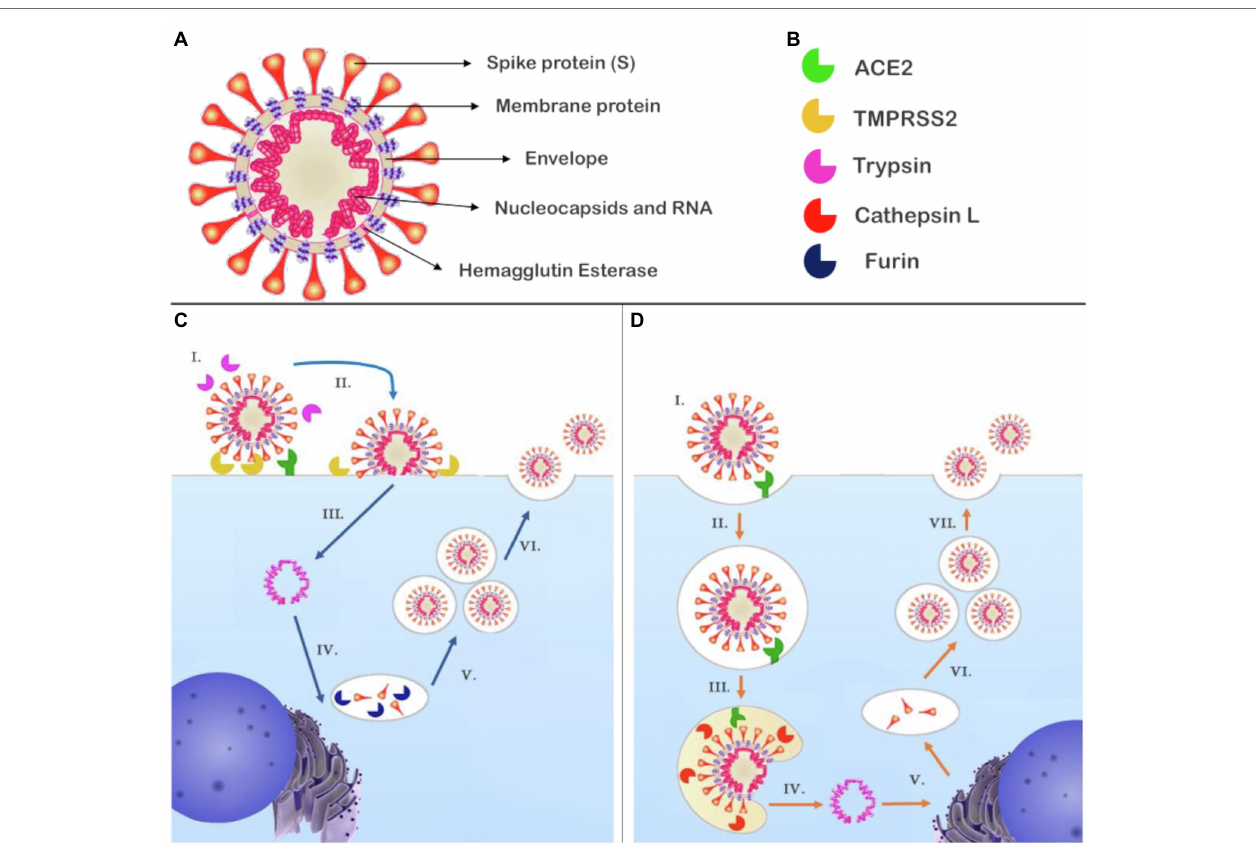
FIGURE 2 | Structure of SARS-CoV-2 and the proposed mechanisms of cell entry and replication. (A) SARS-CoV-2 is composed of RNA contained in nucleocapsids; the envelope retains the genetic material and contains the membrane protein and hemagglutinin esterase dimers. Attached to the envelope is the spike protein (S) responsible for receptor binding. (B) Enzymes reported to participate in the cell entry mechanism of SARS-CoV-2. (C) (I.) SARS-CoV-2 recognizes its receptor, ACE2. The short pathway is possible if S had been primed by furin during biosynthesis and in the presence of TMPRSS2 and/trypsin that cleave S1; (II.) the virus fuses with plasmatic membrane; (III.) releasing its genetic material into the cytosol; (IV.) RNA transcription and replication occur in the cytosol, while the structural proteins are biosynthesized in the endoplasmic reticulum and Golgi apparatus, at this point, furin can prime S at S1/S2; and (V.) New genetic material is encapsulated by envelope and structural proteins generating new virions (VI.) that will be released from the host cell. (D) (I.) The SARS-CoV-2 recognizes its receptor, ACE2. If S had not been primed, a second pathway is activated and (II.) the virus is endocytosed; (III.) Owing to the decreased pH, cathepsin L can be activated and cleaves S1, promoting fusion of the SARS-CoV-2 with the endosome membrane and (IV.) the release of viral genetic material; (V.) RNA transcription and replication occur in the cytosol while biosynthesis of the structural proteins occurs in the endoplasmic reticulum and Golgi apparatus. In this representation, there is no furin to prime S at S1/S2; and (VI.) The genetic material is encapsulated by envelope and structural proteins, generating new virions (VII.) that will be released from the host cell. ACE2, angiotensin-converting enzyme 2; S, spike protein; SARS-CoV-2, severe acute respiratory syndrome coronavirus 2; and TMPRSS2, transmembrane serine protease